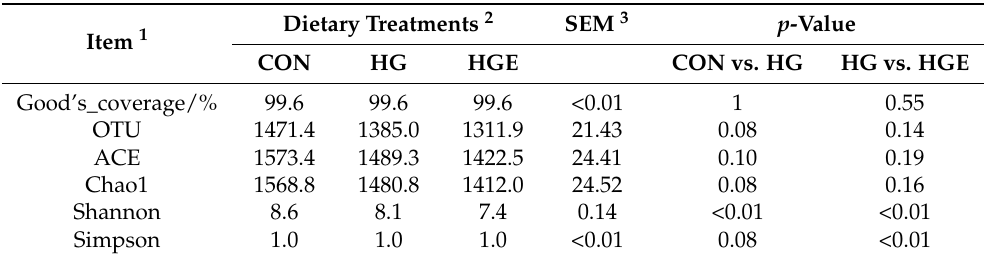
Table 9. Effects of vitamin E on rumen OTUS diversity induced by high concentration in subacute ruminal acidosis cows.